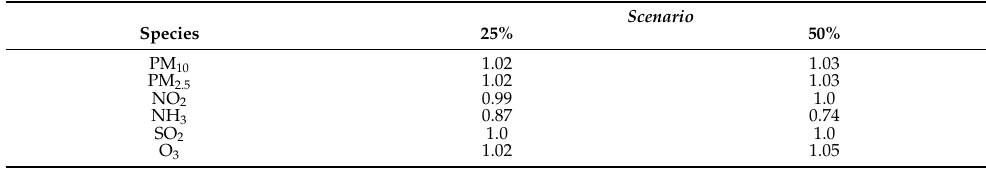
Table 4. Ratio (sum of species/ALL) of concentrations between all individual scenarios summed-up and the scenario with all species (ALL). The data are shown for the averages over all the cells as in the left panel in Figure